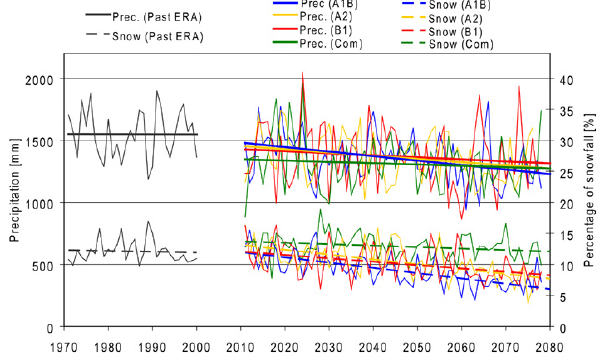
Figure 11. Development of the annual precipitation sum and the percentage of snow precipitation in the UDRB for the past and the four IPCC SRES scenarios from 1971–2080.